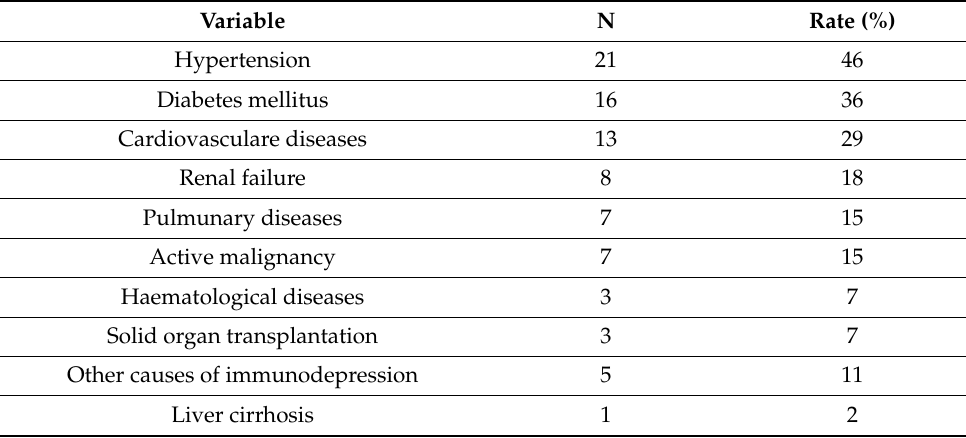
Table 4. Baseline conditions at the